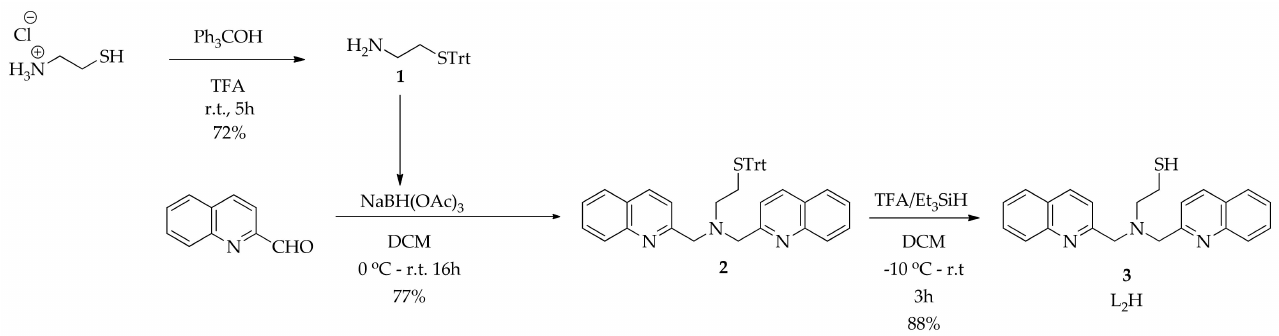
Figure 2. Synthesis of bifunctional ligand L 2 H. The synthesis of L 1 H has been previously reported in the literature